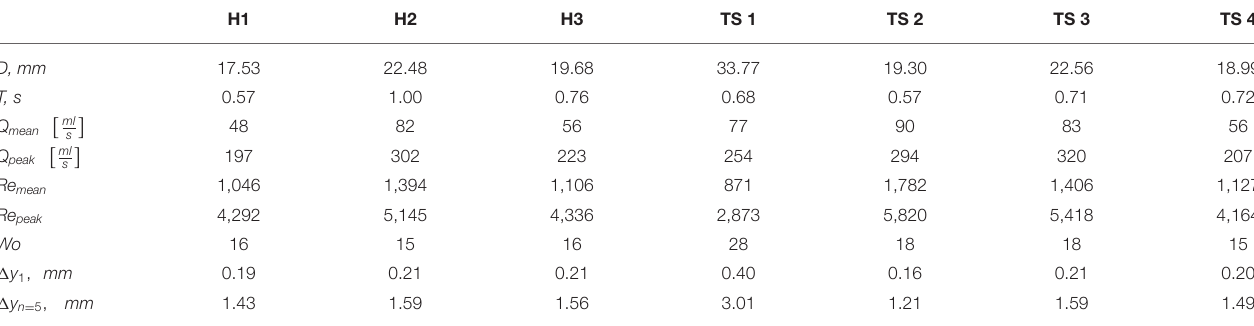
TABLE 2 | Hemodynamic information for healthy (H1–H3) and Turner syndrome (TS1–TS4)